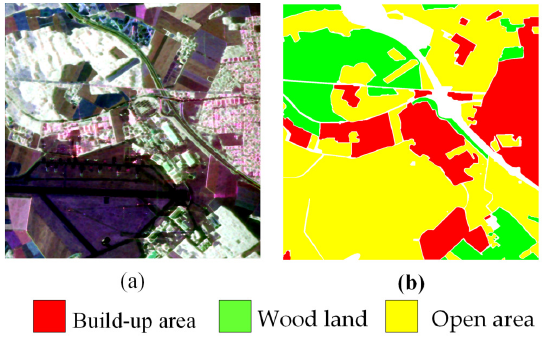
Figure 6. Oberpfaffenhofen image. ( a ) pseudo-RGB image. ( b ) ground